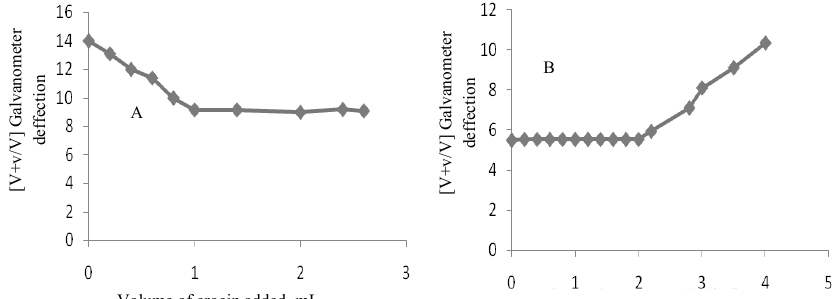
(Figure 5b). The end point indicated crocin: cysteine ratio of 1:2. Amperometric Determination of Crocin in Saffron Stigmas (Crocus